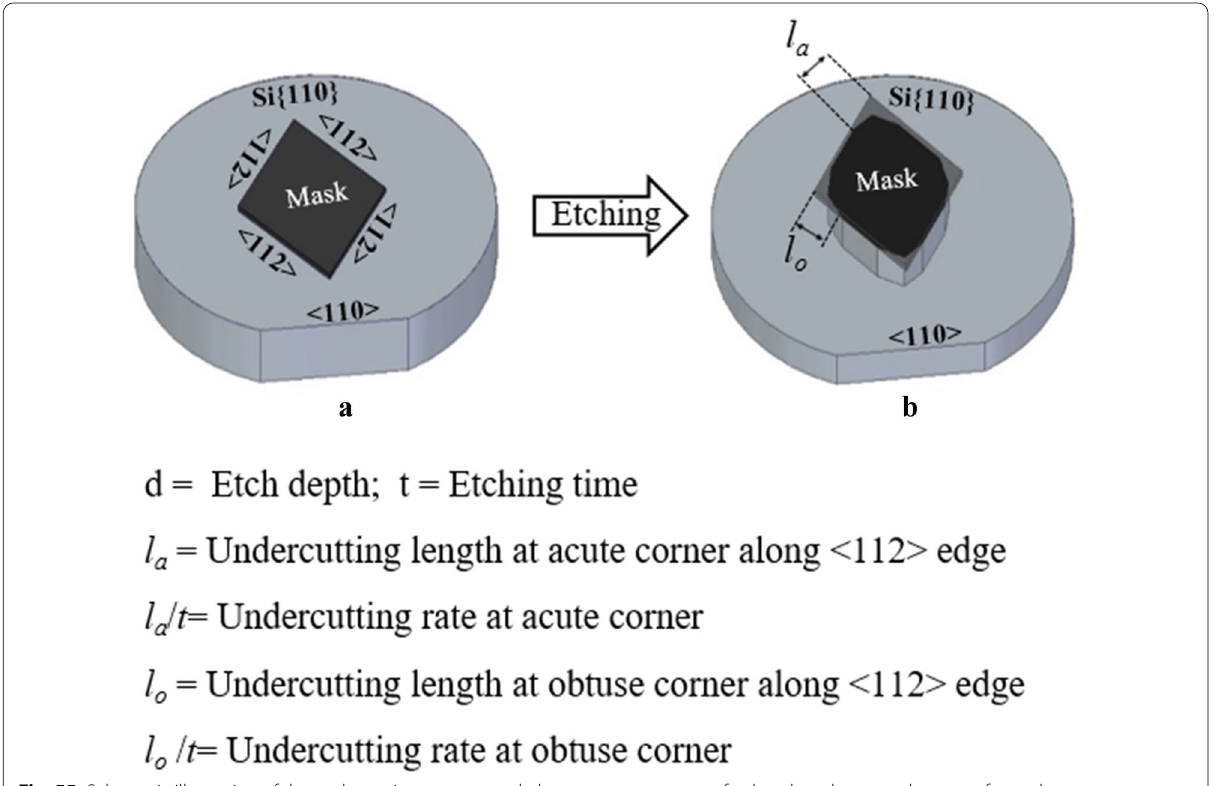
Fig. 55 Schematic illustration of the undercutting at acute and obtuse convex corners of a rhombus shape mask pattern formed by < 112 > directions on Si{110} wafer